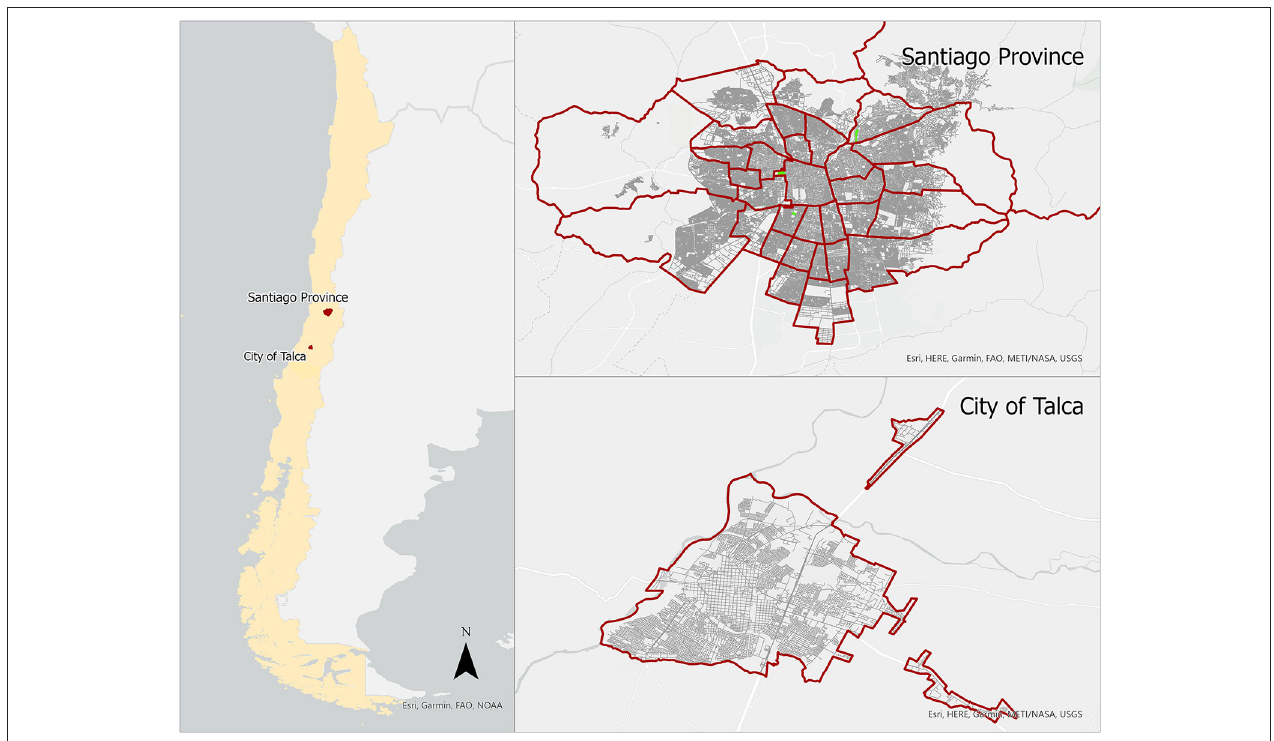
FIGURE 1 | Two study areas in Chile: City of Talca and Santiago